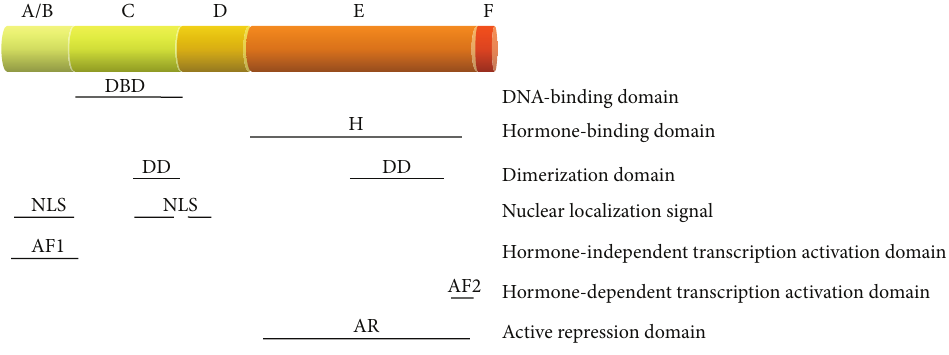
Figure 1: Schematic diagram of nuclear hormone receptor